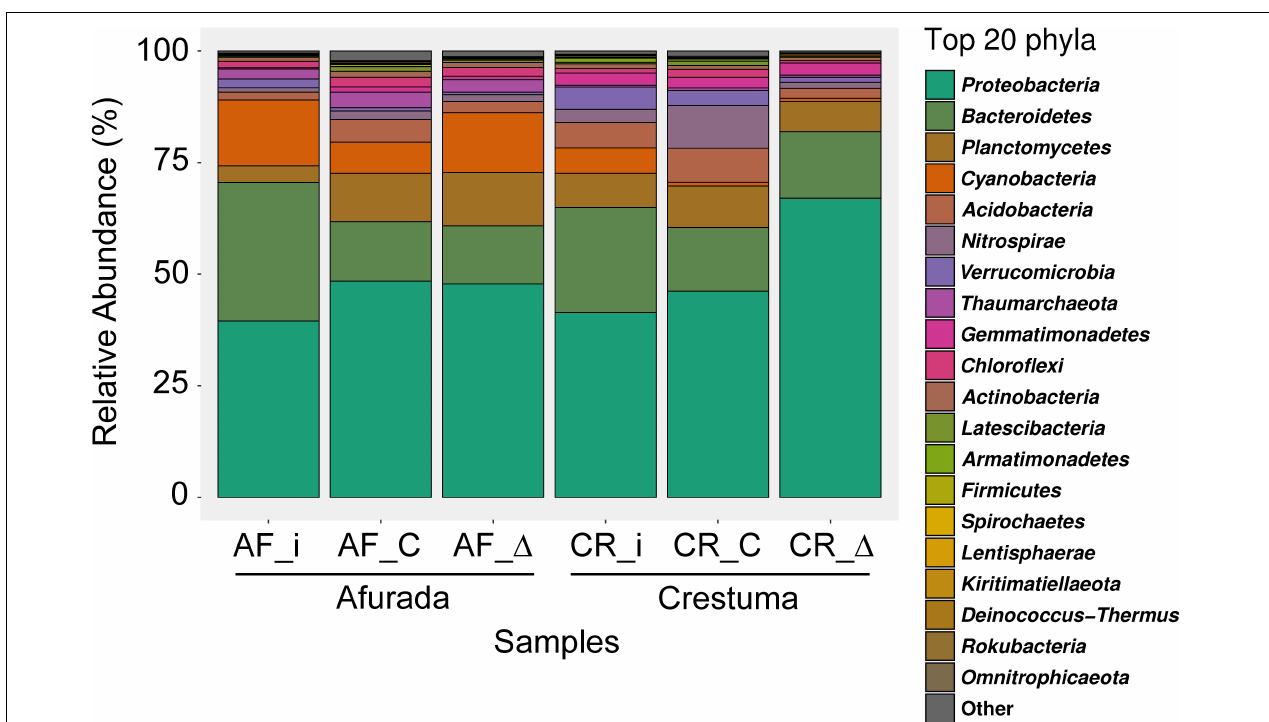
FIGURE 2 | Bar plot representing the relative abundance of the top 20 most abundant prokaryotic phyla from the initial sediment (AF_i and CR_i) and from the sediment samples of the different salinity treatments (constant – AF_C and CR_C, and fluctuation – AF_ (cid:49) and CR_ (cid:49) ). Samples under different salinity treatments were depicted as mean relative abundances of phyla from original sample replicates ( n =